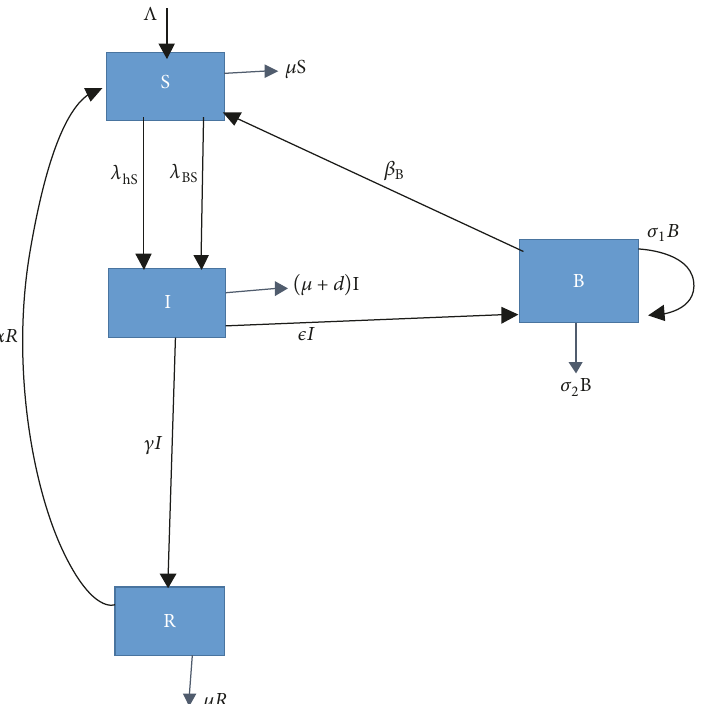
Figure 1: Schematic diagram for the flow of dysentery diarrhea infection.